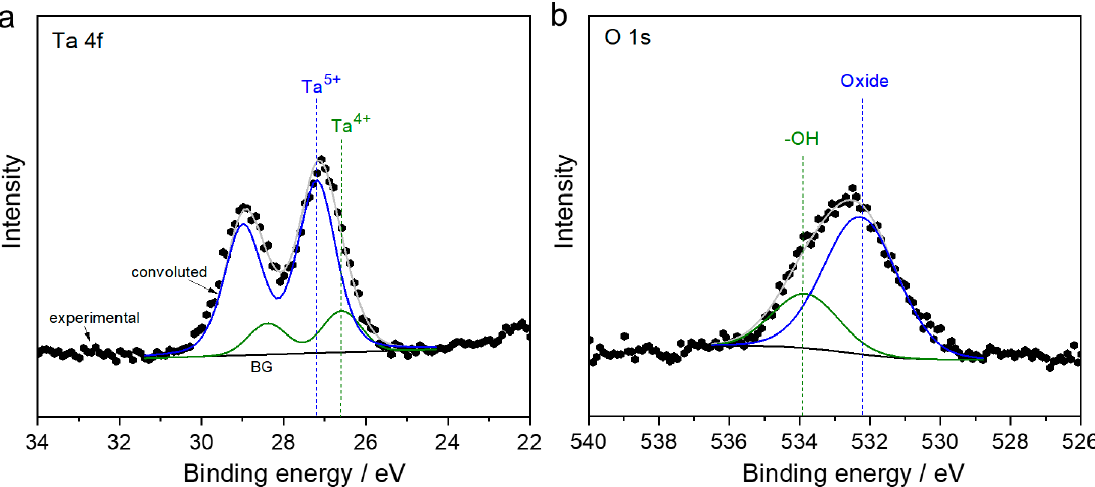
Figure 2. Narrow-scan ( a ) Ta 4f and ( b ) O 1s XPS spectra of ultrafine TaO x /CB nanoparticles prepared by electrodeposition and subsequent annealing treatment in an H 2 flow.